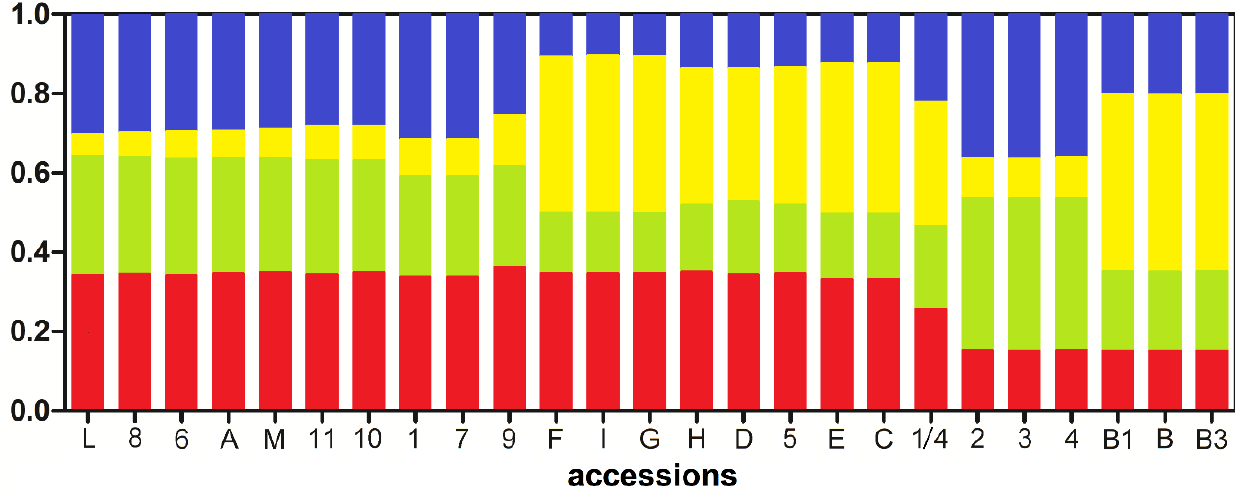
Figure 6. Proportions of the ancestry of 25 S. rebaudiana accessions based on K = 4 (where K is the number of initial subpopulations, each indicated with a different colour). Genotype codes are listed in Table 3 (see Methods).